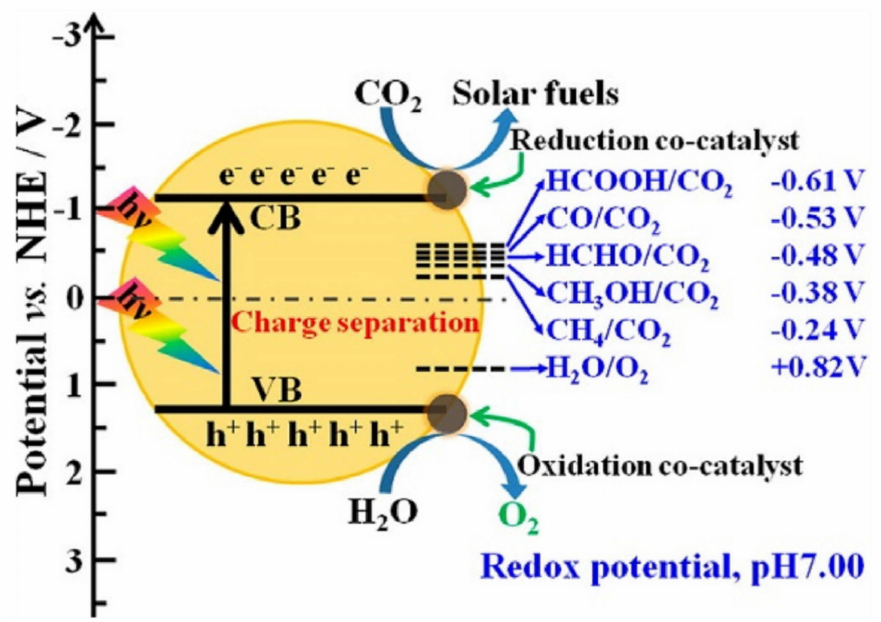
Figure 5. Schematic representation of a typical photoreaction process. Reprinted with permission from American Chemical Society, 20 December 2021 Ref.